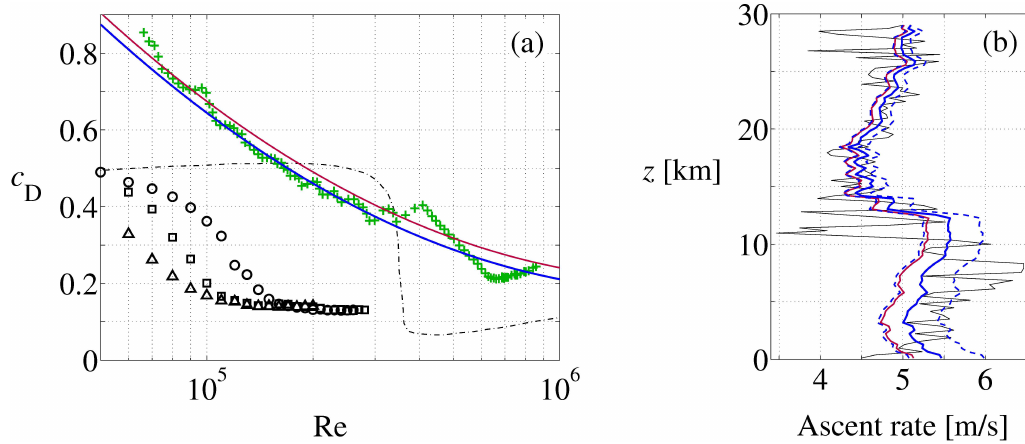
Fig. 6. Evaluation of the model on LUAMI flight L003b launched on 5 November 2008 at 22:45UTC. (a) Corrected reference drag curve (—) obtained by shifting the reference drag curve (—, see Fig. 3) by − 0 . 03 along the c D -axis. The experimental drag curve derived from the flight is indicated by the green crosses. The curves by Achenbach (1972) and Son et al. (2010) for a perfect sphere are reported here for comparison (see Fig. 1). (b) Vertical profile of the balloon ascent rate in still air derived from the corrected drag curve (—), and the lower and upper limits of its range of uncertainty (–––). The ascent rate in still air derived from the non-corrected reference drag curve (solid purple curve in panel (a) ) is indicated here for comparison (—), along with the 60s-low pass filtered ascent rate calculated from the GPS data